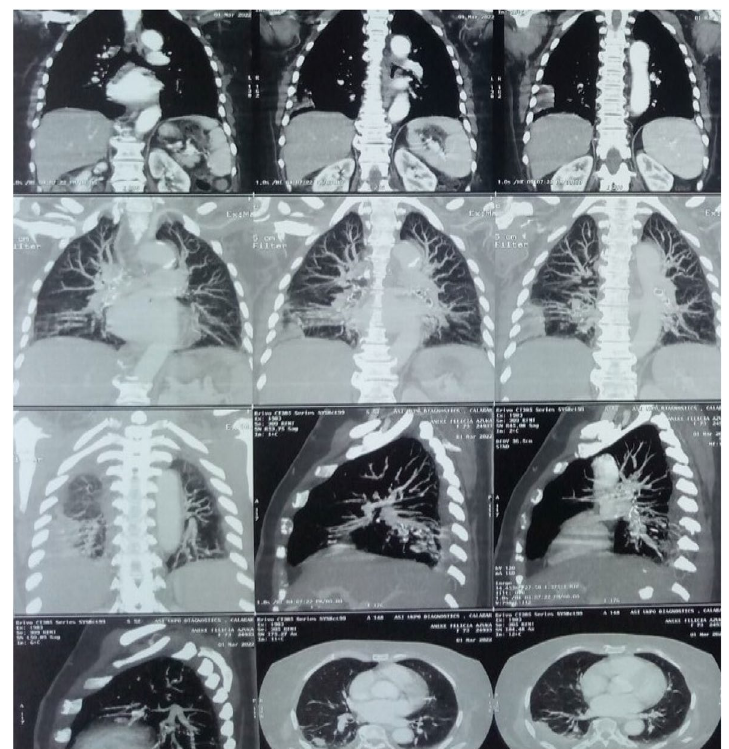
Fig. 3 HRCT chest (contrast-enhanced) showing filling defects within the pulmonary arteries at the segmental and sub-segmental levels, pulmonary plethora, and right lower lobar